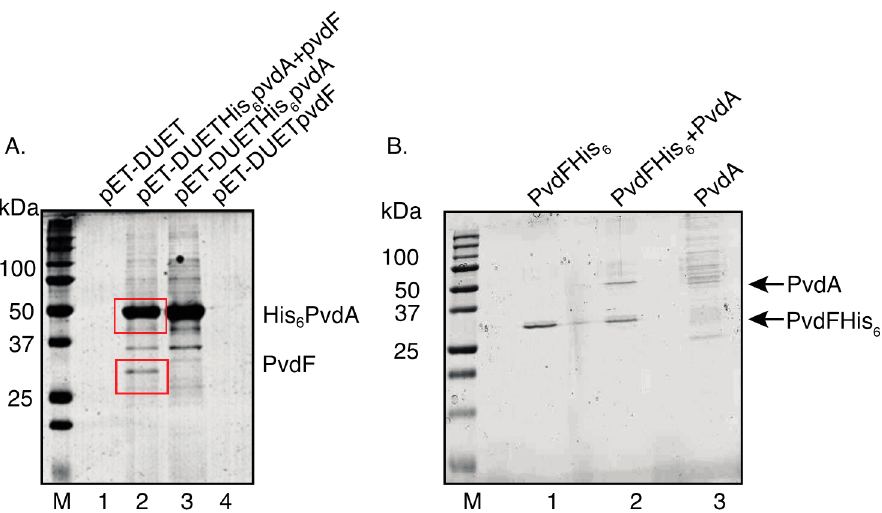
Figure 7. Co-purification of PvdF and PvdA ( A ) PvdF and His 6 PvdA were expressed from pET- DUET-1 in E. coli BL21 DE3. Following purification by nickel affinity chromatography, proteins from bacteria containing the plasmids shown were visualised by SDS-PAGE. The identities of the bands in red boxes were confirmed as His 6 PvdA and PvdF by mass spectrometry (Table S1). ( B ) PvdFHis 6 and PvdA were expressed separately in E. coli BL21 DE3 and cell lysates prepared. Nickel affinity chromatography was carried out on individual lysates (PvdFHis 6 ; PvdA) and following mixture of lysates (PvdFHis6 and PvdA). The eluates were analysed using SDS-PAGE. The positions of PvdFHis 6 and PvdA proteins are indicated.